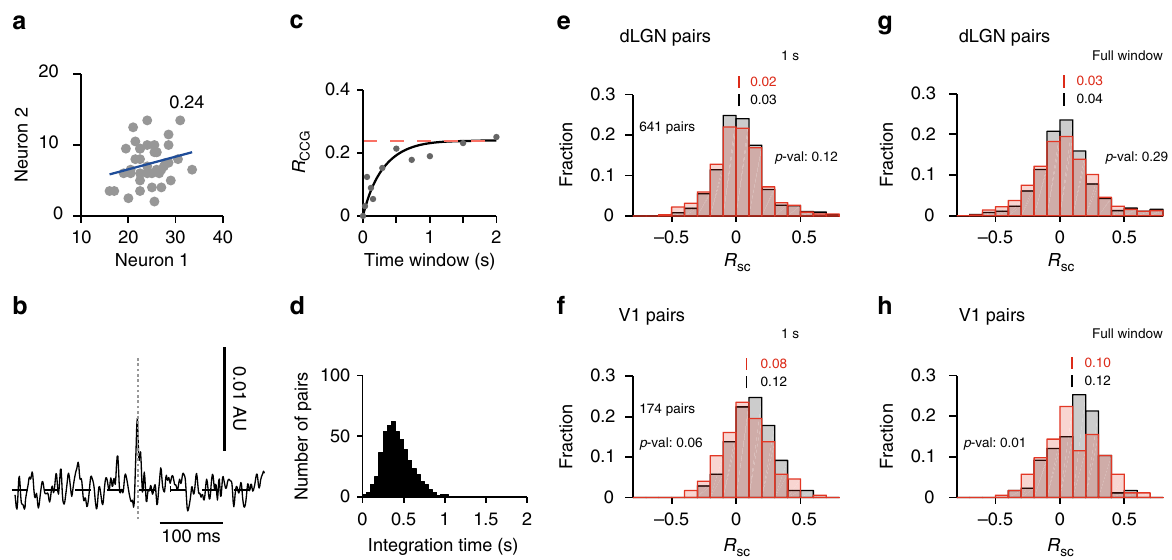
Fig. 5 Weak impact of locomotion on pairwise activity correlations. a Trial-to-trial spike count responses of a correlated dLGN cell pair. Units are spike/s. b Example cross-correlogram (CCG) of a correlated dLGN cell pair. c R CCG (see Methods) for the pair in a . Red line indicate spike count correlation R SC ; black line is the exponential fi t. Note how the R CCG converges to the spike count correlation ( R SC ) for large window sizes. d Distribution of integration time from exponential fi ts to the R CCG for a sample of dLGN and V1 cell pairs. e Distributions of spike count correlations of dLGN cell pairs (641 pairs) in locomotion (red) and stationary (black) trials. Spike counts calculated using 1 s windows, starting 0.5 s after stimulus onset. f Same as e for V1 cell pairs (199 pairs). g Distribution of spike count correlations of dLGN cell pairs using the entire 2 s stimulus windows. h Same as g for V1 cell